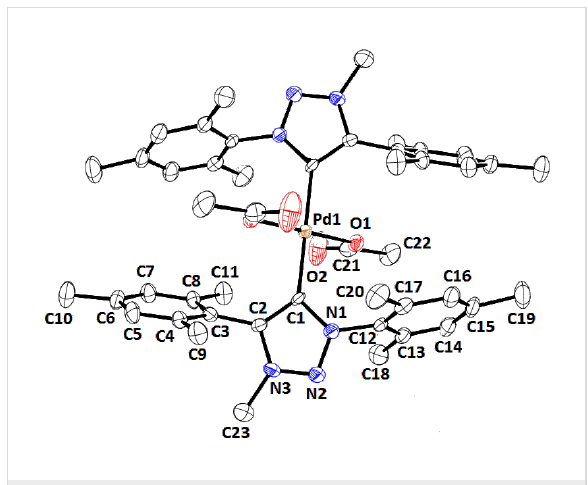
Figure 3: ORTEP representation of the structure of complex 2 in the crystal (35% probability ellipsoids). Hydrogens are omitted for clarity.